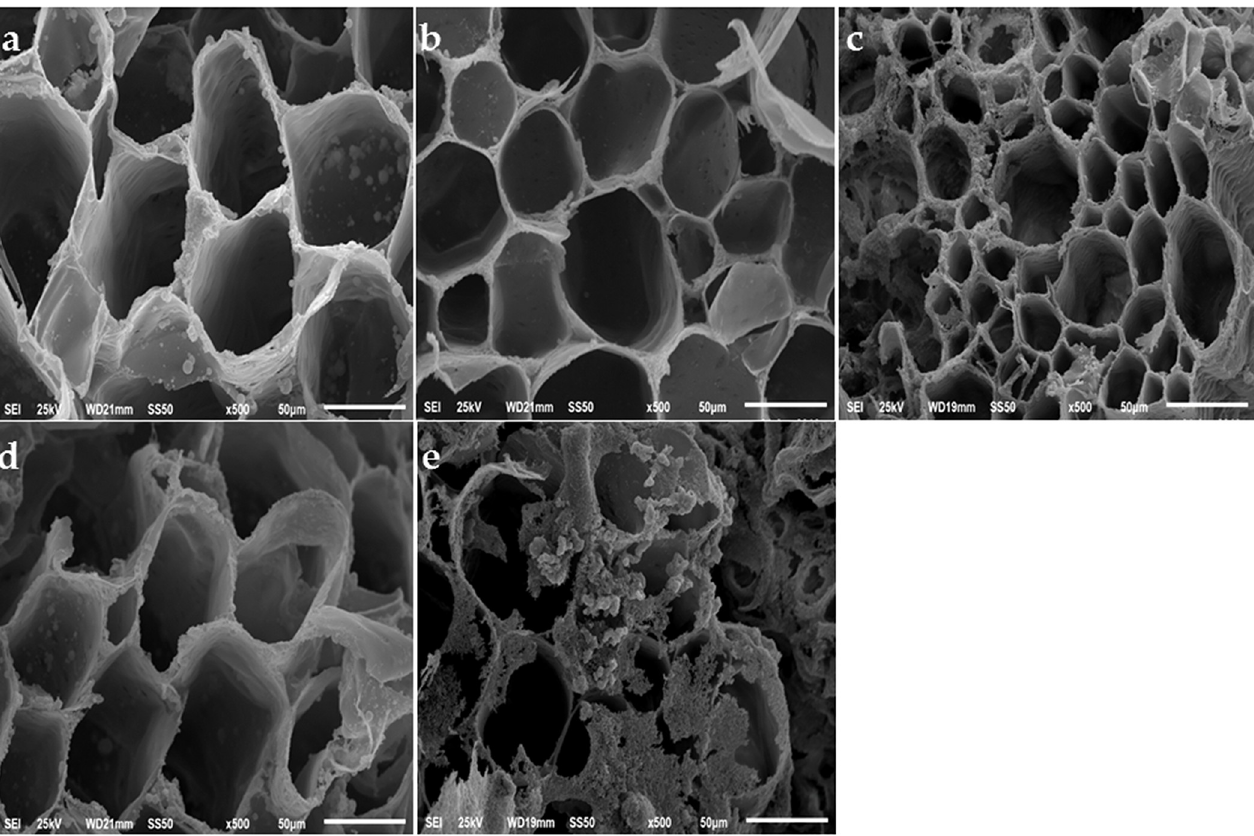
Fig 7. Carnation stem cross section at the base of cut flower stems a: geranium, b: thyme, c: marjoram; d: anise, and e: untreated flowers. The section was made at the end of the vase life of each treatment (Magnification:1500x).